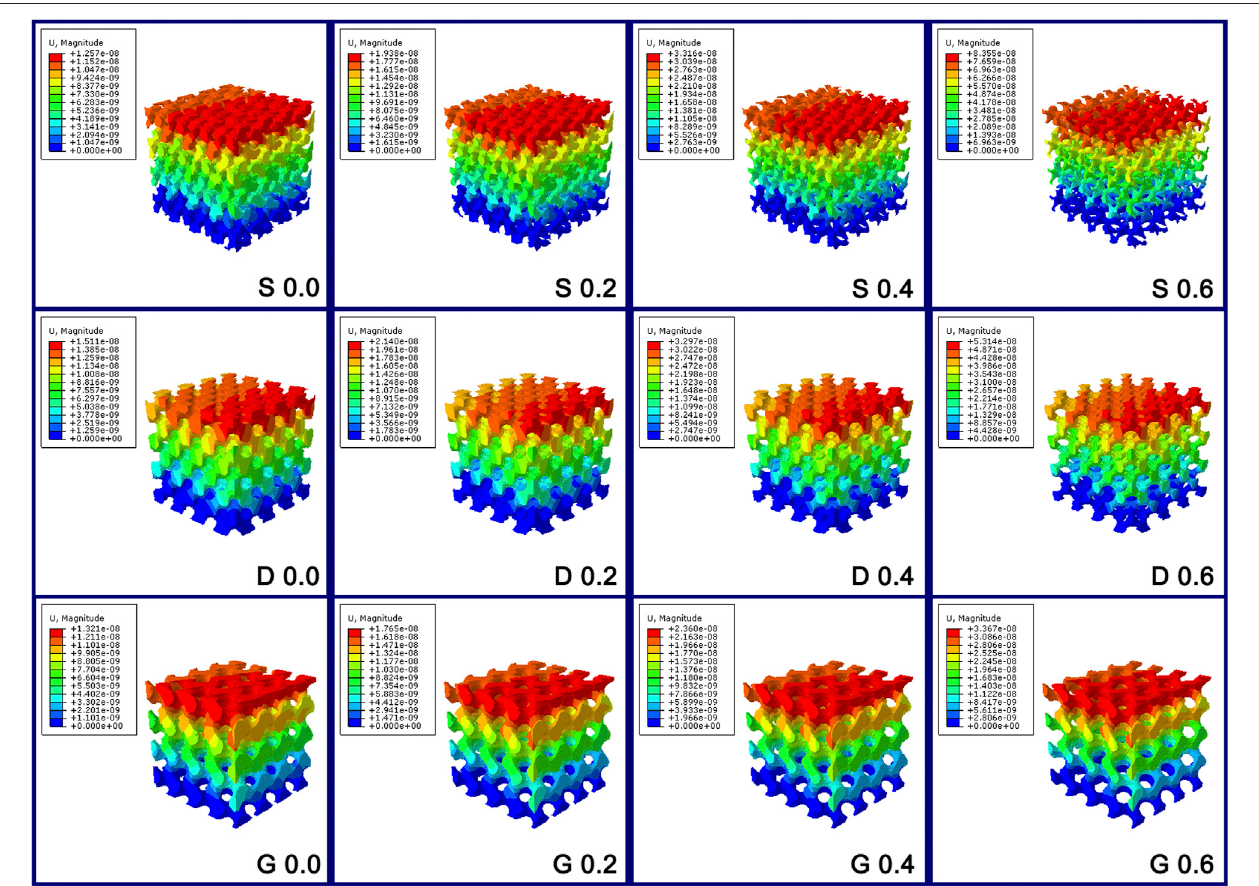
FIGURE7| Thedisplacementdistributiondiagramoftheporousscaffoldsthroughthe fi niteelementanalysis.Themaximumdisplacementvaluevariationtendency in S porous scaffolds was steep; however, that of G porous scaffolds was smooth.